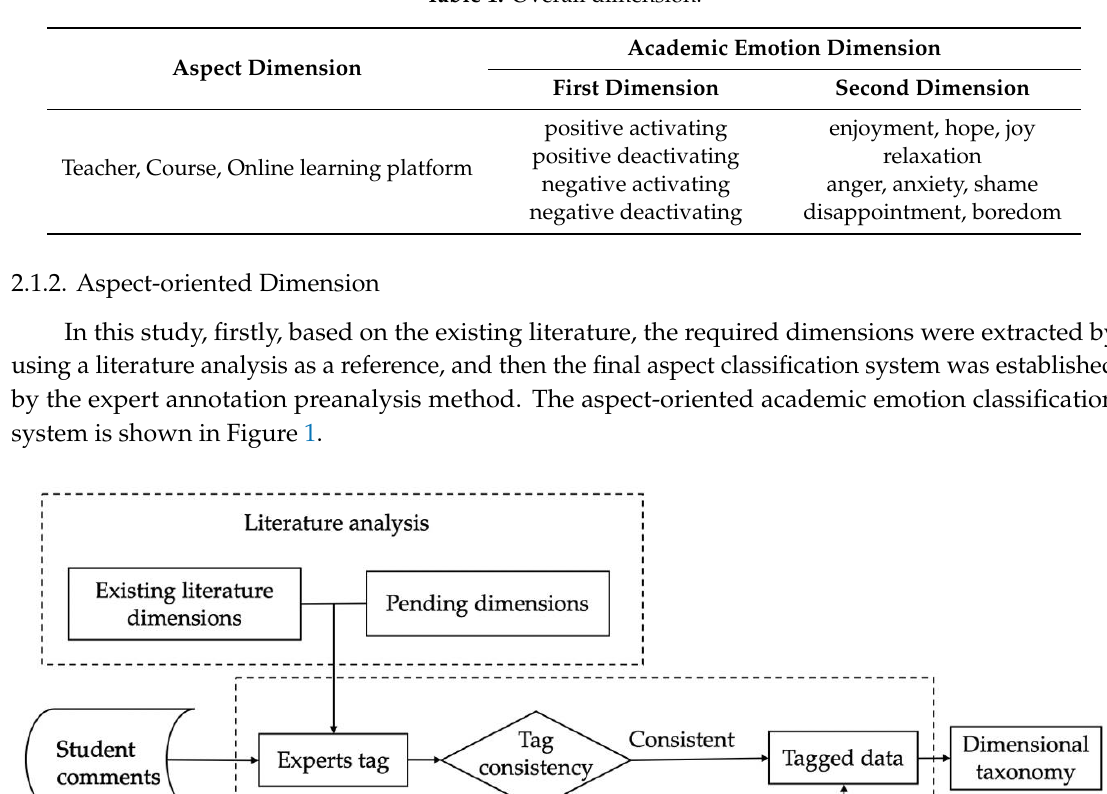
Table 1. Overall dimension.